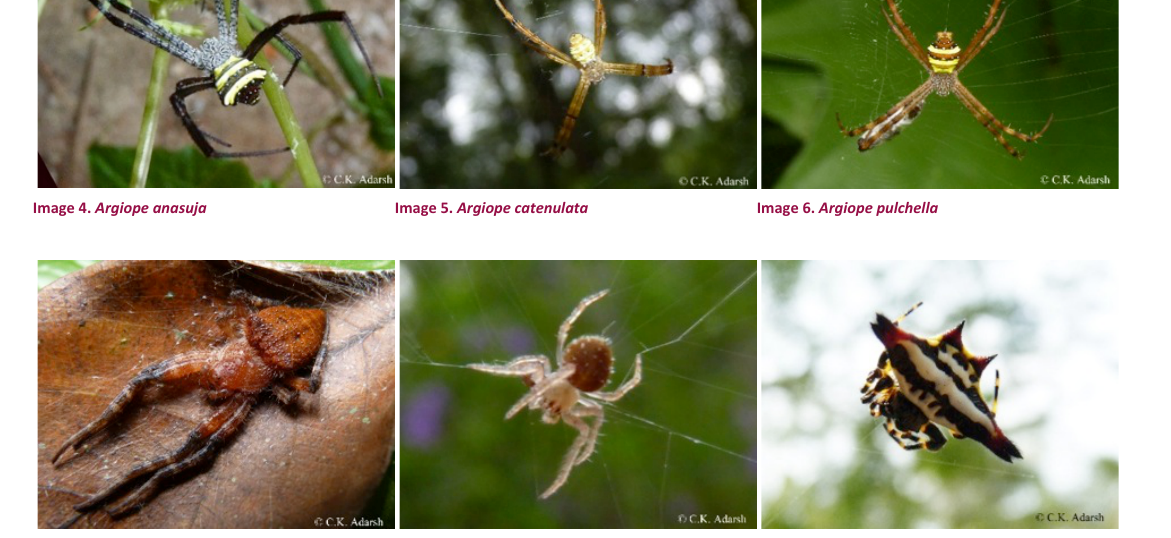
Image 7. Cyrtophora unicolor Image 8. Eriovixia laglaizei Image 9. Gasteracantha